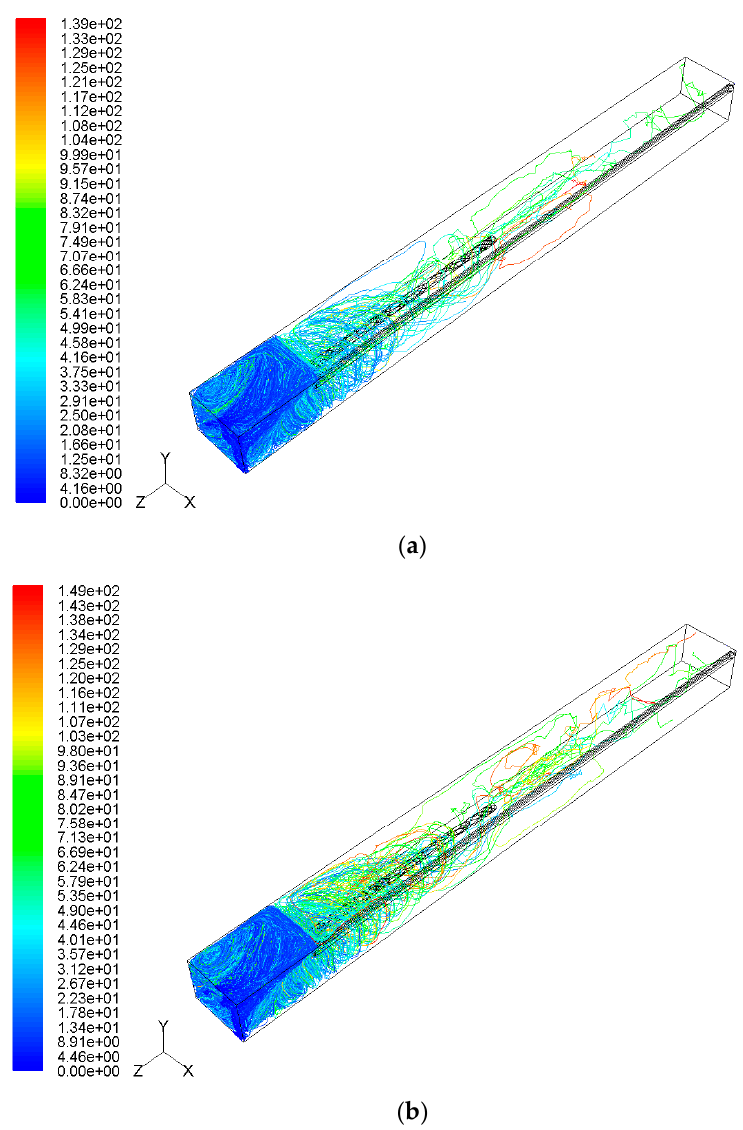
Figure 13. Coal dust trajectories for vortex ventilation system colored by particle residence time(s).